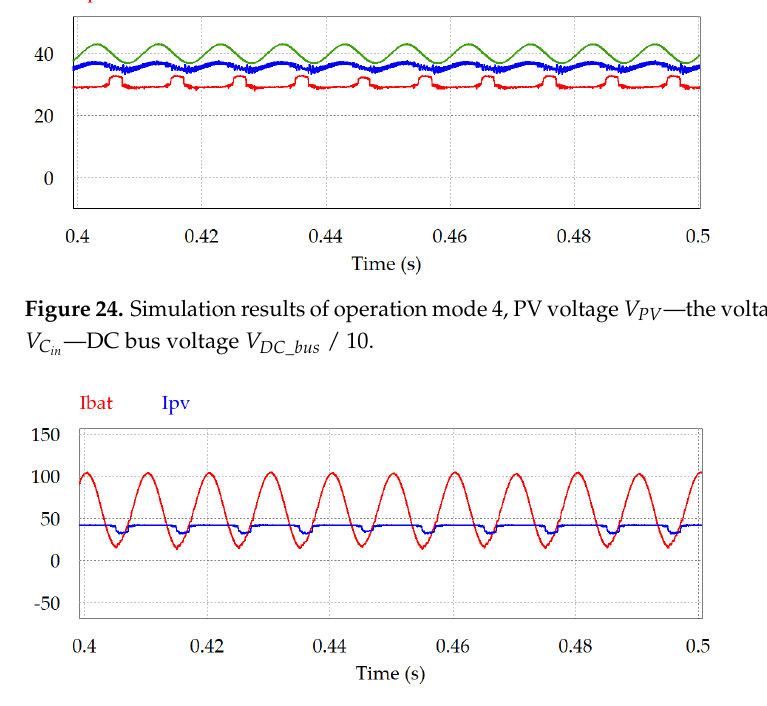
Figure 25. Simulation results of operation mode 4, PV input current I PV —Battery discharging current I bat